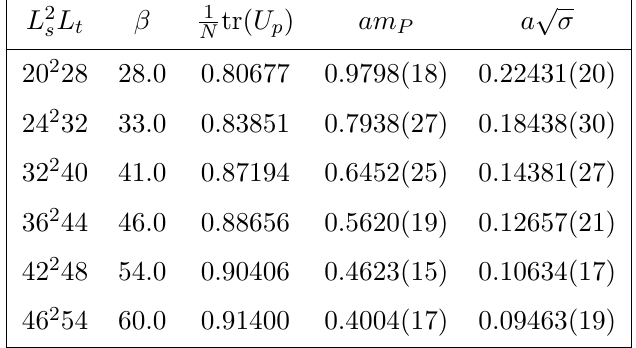
Table 14 . SO(6) average plaquette values, (cid:13)ux loop masses, and string tensions.